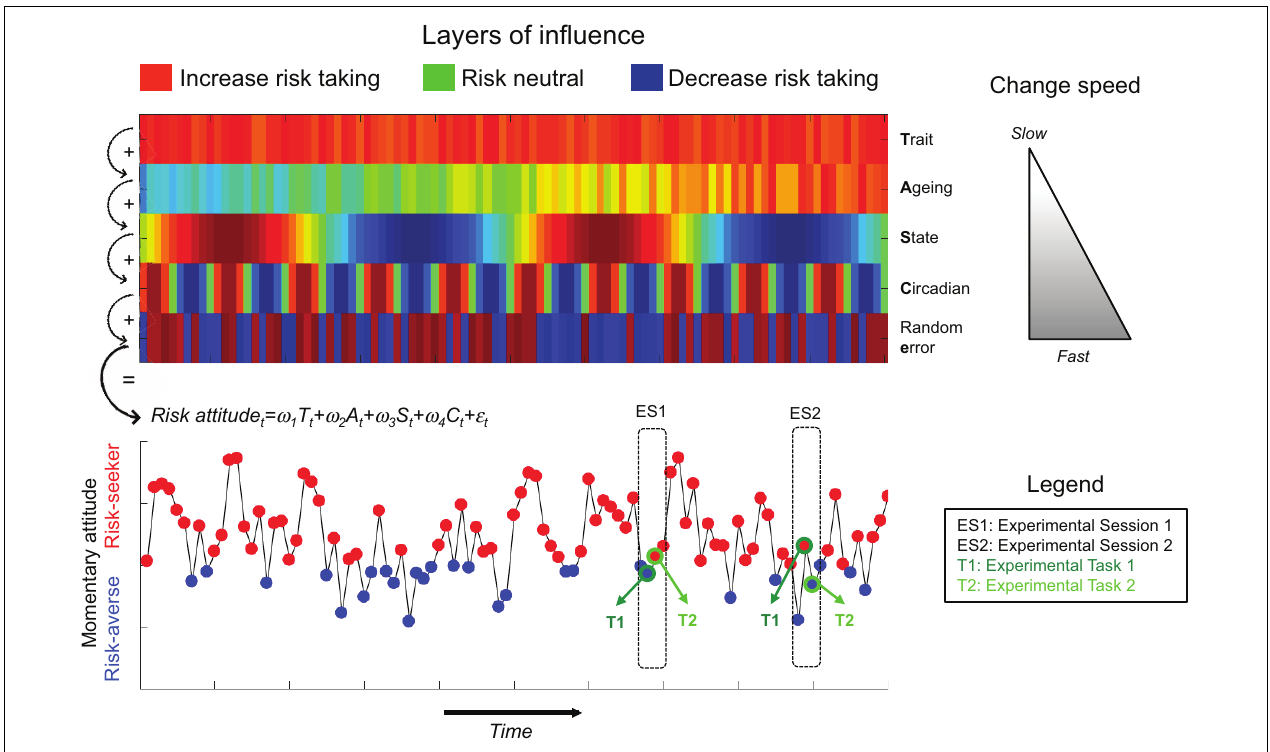
FIGURE 1 | The figure schematizes how low consistency of behavioral measures of risk may arise from the multi-layer model. At the top, we represent the different factors that influence the probability to express a given behavioral phenotype at a given time point in addition to random error. We consider a simplified case in which only two phenotypes are possible: red (risk seeking) and blue (risk aversion). The different layers change at different time constants (as exemplified by the gray triangle on the right). At a given time point (t) the momentary risk attitude is the weighted sum of the different layers of influence plus random error. A given subject is tested in two experimental sessions (ES1, and ES2) with two behavioral tasks supposed to measure the same behavioral phenotype (T1 and T2). The multi-layer model may explain why behavioral measures are not consistent between-tasks and